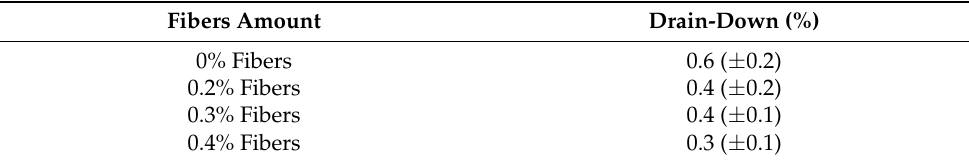
Table 4. Average drain-down results for the shredded